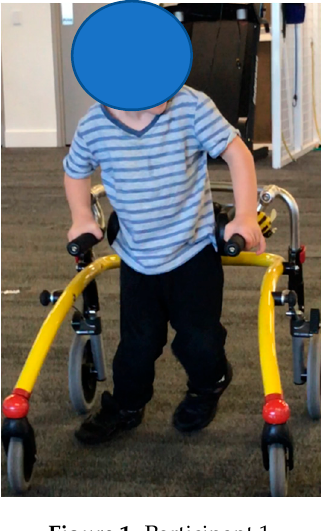
Figure 1. Participant 1. Table 2. Participant 1 outcome measure comparative results between and sensomotoric orthoses (SMotOs) and ankle–foot orthoses